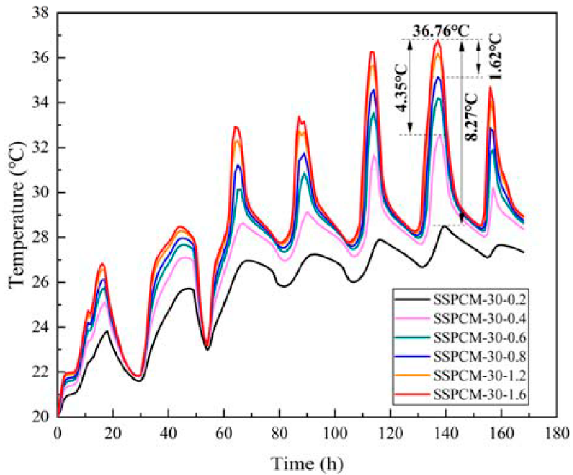
Figure 16. The internal surface temperature of the SSPCM layer at different thermal conductivities.